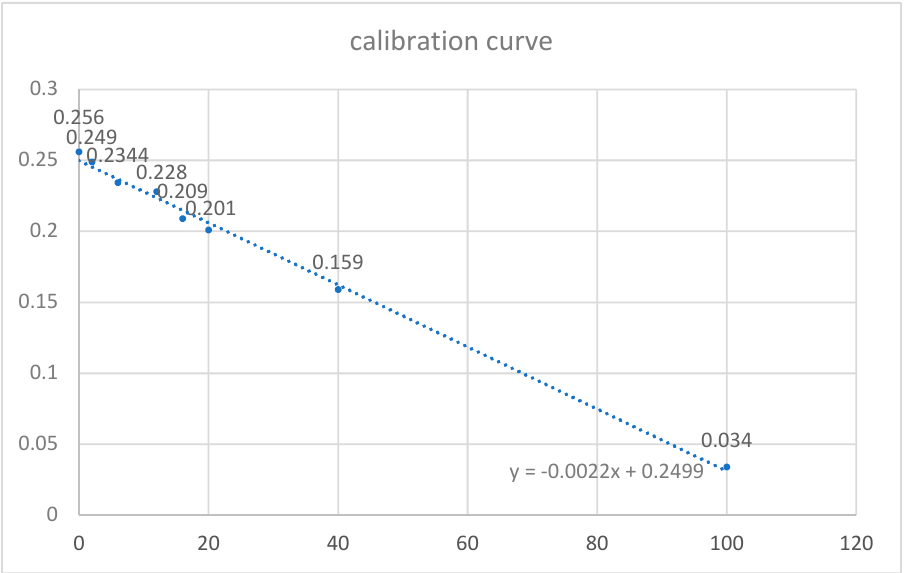
Figure 1. Calibration curve for fluoride ion concentration based on color complex formation between iron ions and indole − 3 − acetic acid.